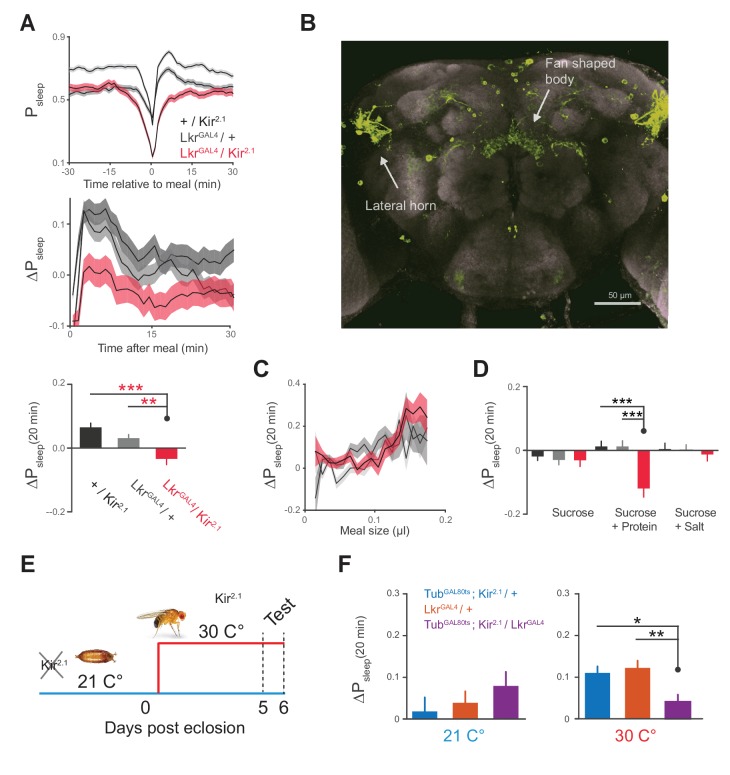
Leucokinin receptor neurons regulate protein-induced postprandial sleep.(A) Overexpression of Kir2.1 channel in cells labeled by LkrGAL4 (R65C07) results in a defective postprandial sleep response (20 flies per genotype, n = 697 meals, Kir2.1 / wCS; 762, LkrGAL4 / wCS; 450, Kir2.1 / LkrGAL4; *p<0.05; ***p<0.001, Kruskal-Wallis test followed by Dunn’s multiple comparisons). (B) LkrGAL4 drives mCD8-GFP expression in neurons innervating the dorsal fan-shaped body, stemming from cell bodies in the lateral horn (scale bar = 50 µm). (C) Average 20 min ΔPsleep for Kir2.1-silenced LkrGAL4 animals and controls given low nutrient food (1% sucrose, 0.25% tryptone) for observing volumetric effects (n = 1589–1736 meals per genotype). (D) Average 20 min ΔPsleep for Kir2.1-silenced LkrGAL4 animals and controls given salt (2.5% sucrose + 1% salt) or protein (2.5% sucrose + 1.7% tryptone) diet to test meal component influences on postprandial sleep. The silenced line shows a negative response to protein supplemented diet (***p<0.001, Kruskal-Wallis test followed by Dunn’s multiple comparisons). n = 257–444 meals per genotype. (E) Expression of Kir2.1 can be restricted by using temperature-sensitive GAL80ts to suppress GAL4 activity at 21°C throughout development. (F) Silencing of LkrGAL4-labeled cells in adulthood (30°C) is sufficient to reduce postprandial sleep (24 flies per genotype, n = 493 meals, TubGAL80ts; Kir2.1/ wCS; 499, LkrGAL4/ wCS; 528, TubGAL80ts; Kir2.1/ LkrGAL4; *p<0.05; **p<0.01, Kruskal-Wallis test followed by Dunn’s multiple comparisons).